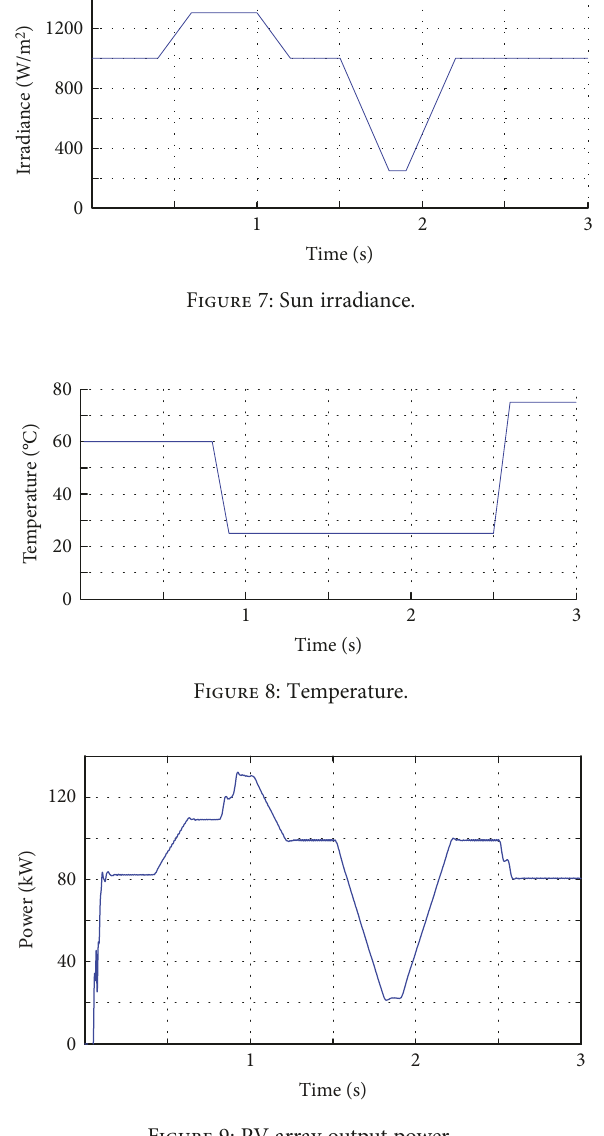
Figure 9: PV array output